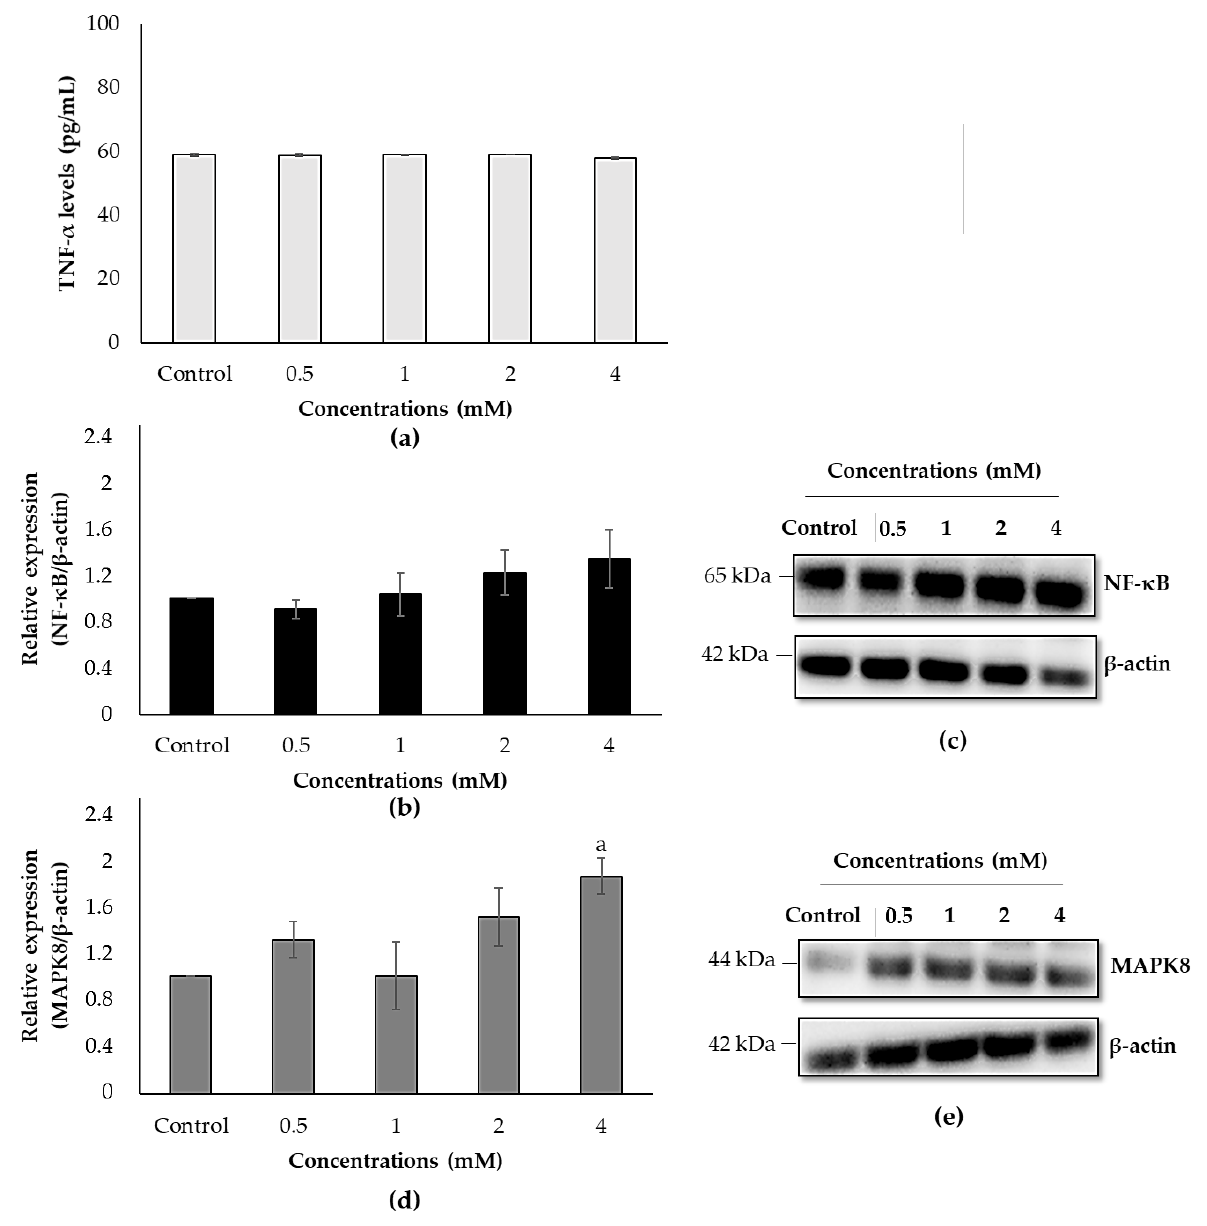
Figure 7. Effects of ACE on ( a ) TNF- α levels, ( b ) NF- κ B and ( d ) MAPK8 protein expressions in SH-SY5Y cells after 24 h exposure. Representative membrane images of ( c ) NF- κ B and ( e ) MAPK8. Data are presented as mean ± SD; and statistically significant changes are indicated as a: p < 0.05.